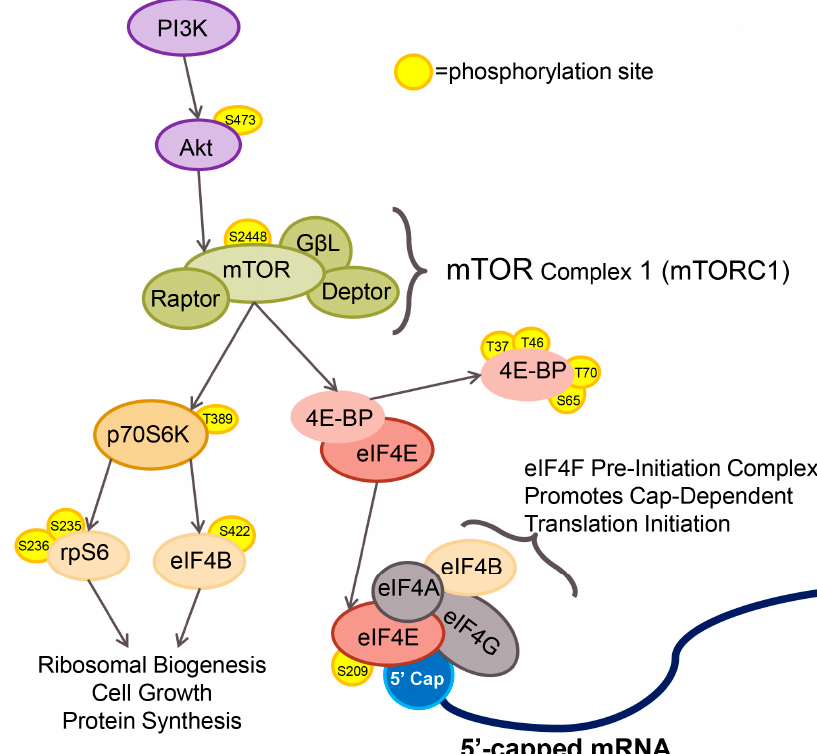
Figure 1. The mammalian target of rapamycin complex 1 (mTORC1) pathway and translation initiation. Cellular mTORC1 activity is regulated in part by phosphatidylinositol-3-kinase/protein kinase B (PI3K/Akt) signaling. Phosphorylation of mTOR on residue serine 2448 leads to activation of mTOR and phosphorylation of mTORC1 effector proteins, 70 kDa ribosomal protein S6 kinase 1 (p70S6K) and eukaryotic initiation factor 4E binding protein (4EBP). Phosphorylation-induced activity of p70S6K phosphorylates ribosomal protein S6 (rpS6) and eukaryotic initiation factor 4B (eIF4B) resulting in initiation of specific cap-dependent translation events. mTORC1-dependent phosphorylation of 4EBP leads to dissociation of 4EBP from eIF4E. Free eIF4E binds to the 5 (cid:48) cap of host mRNAs and forms the eIF4F pre-initiation